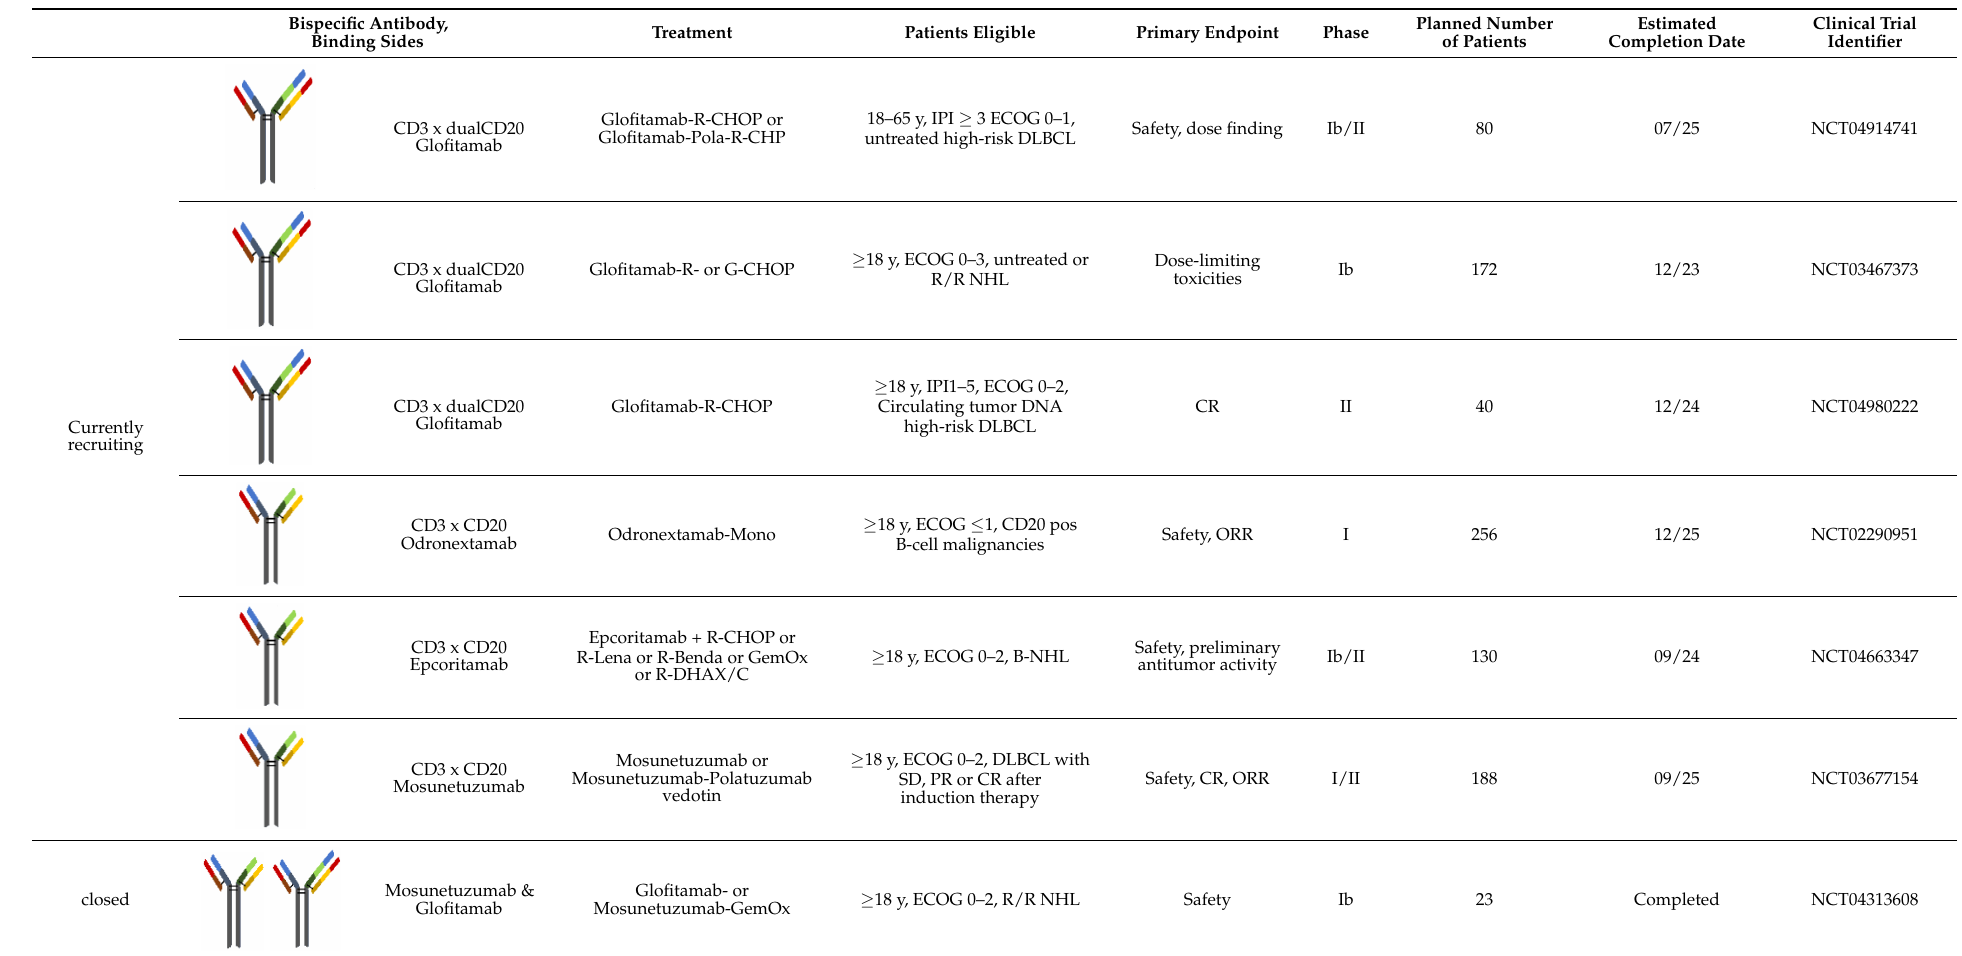
Table 3. Ongoing clinical trials investigating bispecific